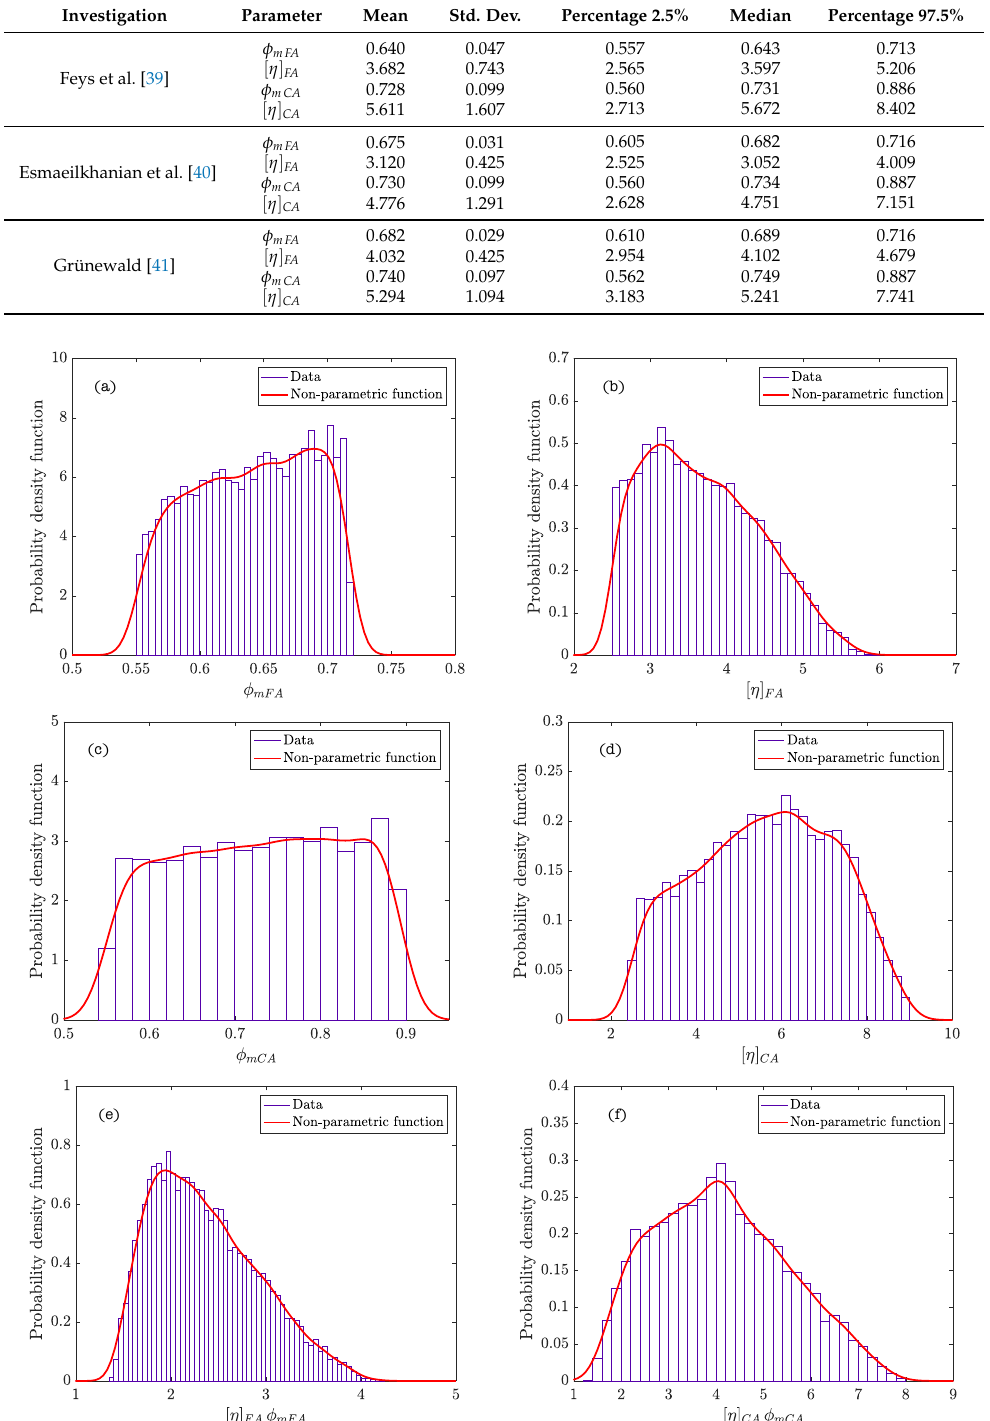
Table 7. Statistics of the parameters φ mFA , φ mCA , [ η ] FA , and [ η ] CA for self-compacting concretes.